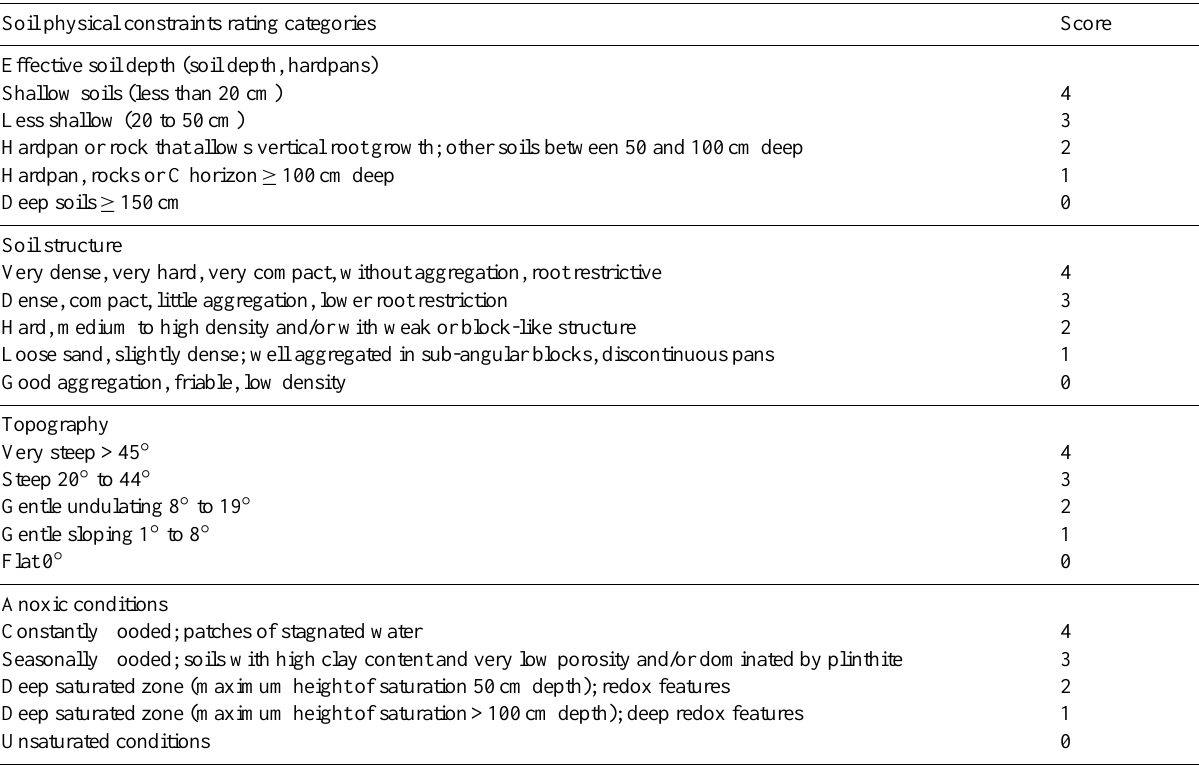
Table 2. Score table for physical soil constraints (withdrawn and adapted from Quesada et al., 2010). Anoxic conditions were referred to as “water saturation index” in the present